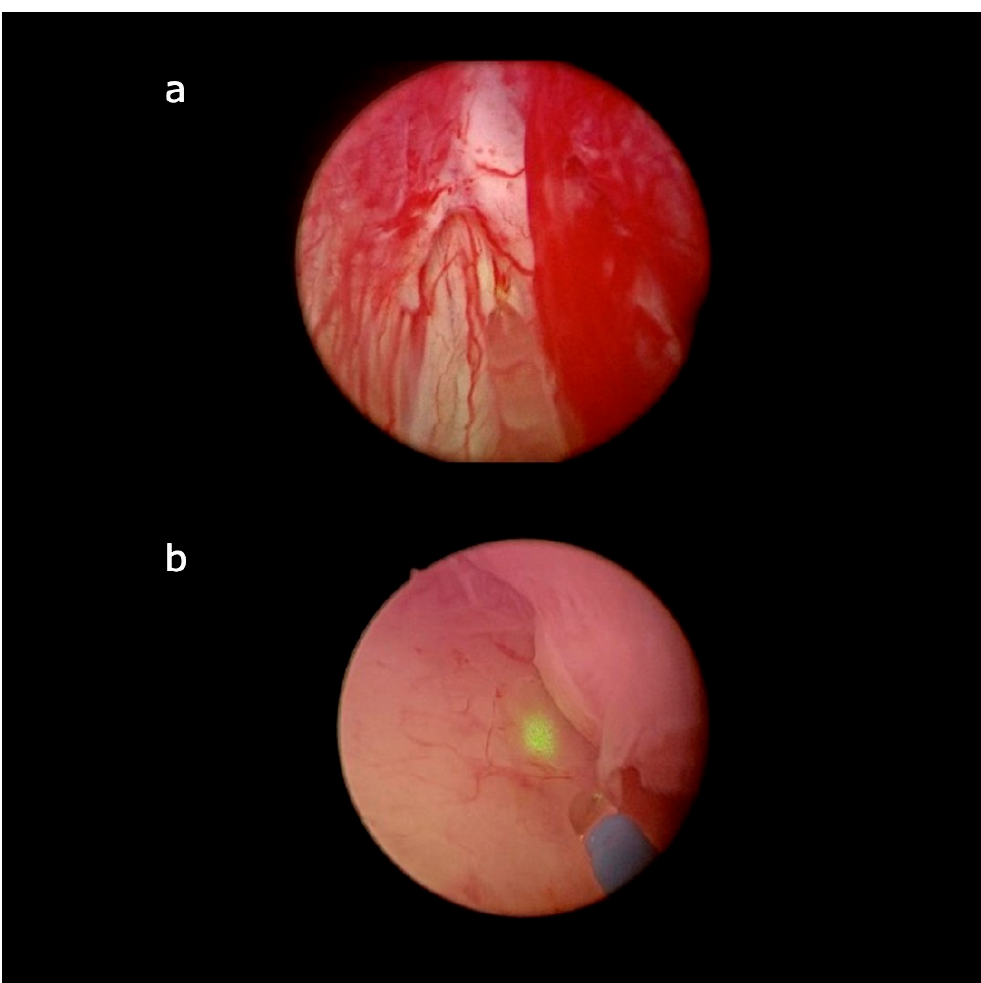
Appl. Sci. 2021 , 11 , 2467 Figure 2. Para-collicular incision site ( a ) at the 5 and 7 o’clock positions to identify the dissection plane ( b ).